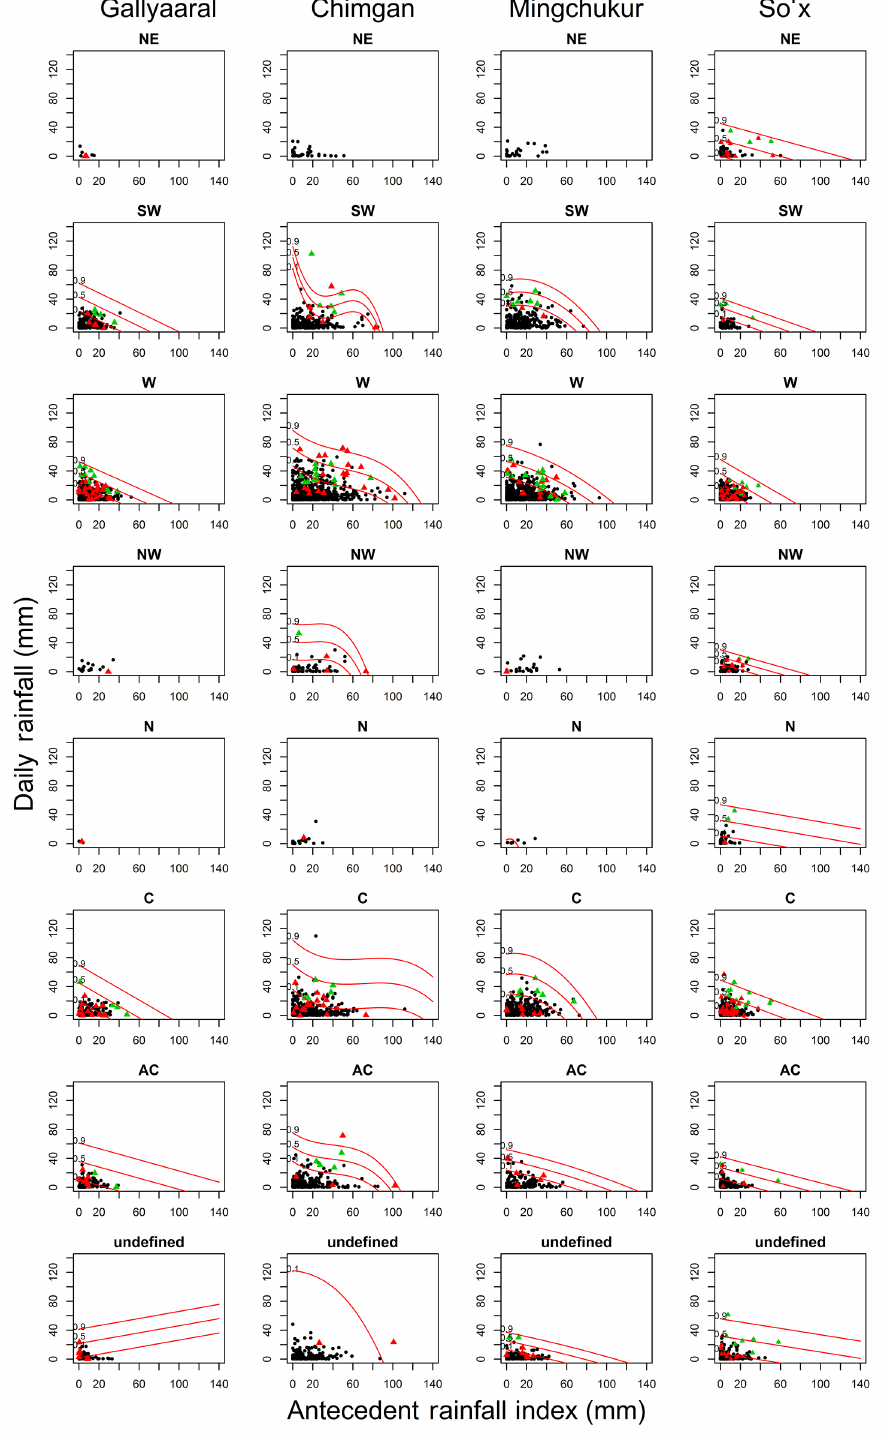
Figure 15. Threshold probabilities initiating mudflow occurrences for each CWT class at the stations Gallyaaral, Chimgan, Mingchukur and So’x (panel columns) for the period of March–April 1984–2013. The black dots are days without mudflow, the green triangles are days with probable mudflow and the red triangles are days with initiated mudflow occurrences in the study area. Red lines and curves indicate the 0.1, 0.5 and 0.9 probability thresholds triggering mudflow occurrences for each CWT